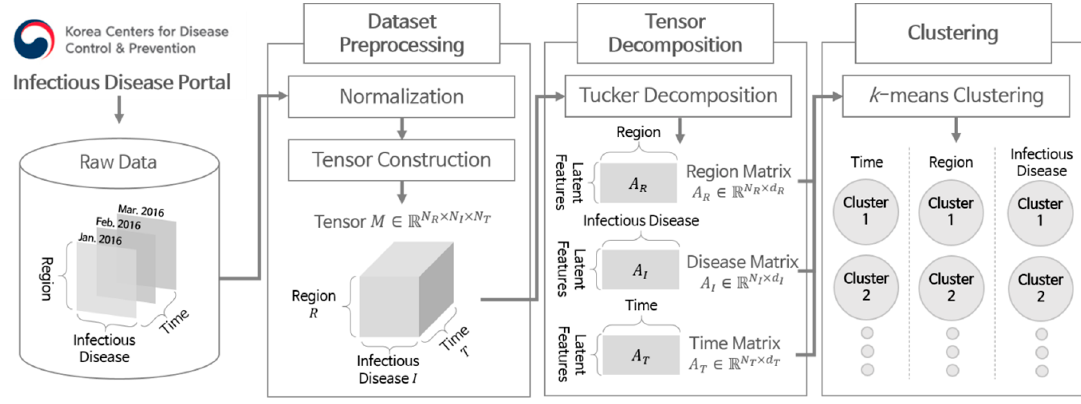
Figure 1. Overall steps for data analysis.